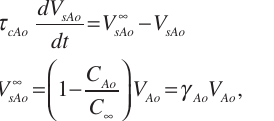
Figure 1. Simulated aortic mechanics. A . The aortic pressure time course obtained from Coleridge et al. 11 is used as the input to the aortic mechanics model module, Equation (4). B . The model- predicted relationship between aortic pressure and diameter